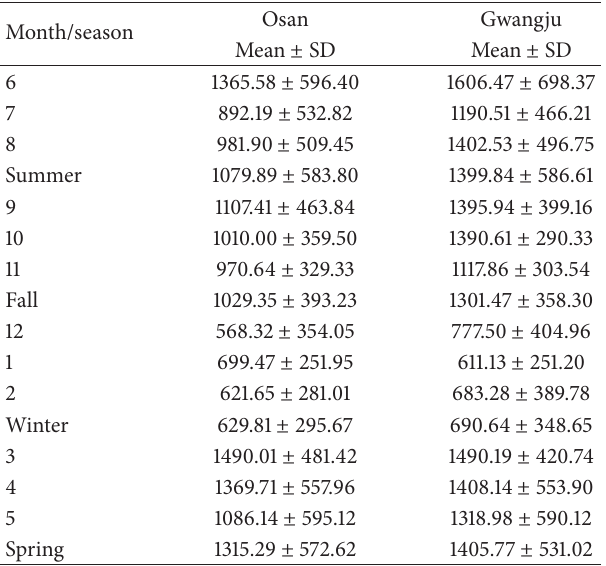
Table 1: Monthly and seasonal mean and standard deviation (SD) of model DMMH